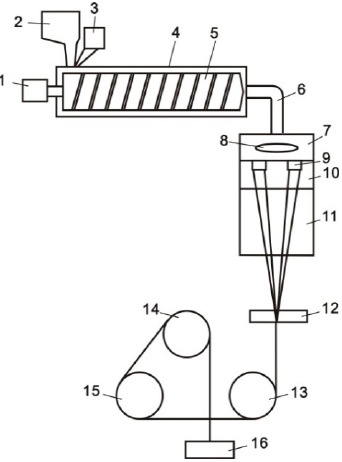
Figure 2. Sketch diagram of melt spinning of CNTs/PLA composite filaments. 1—screw machine, 2—